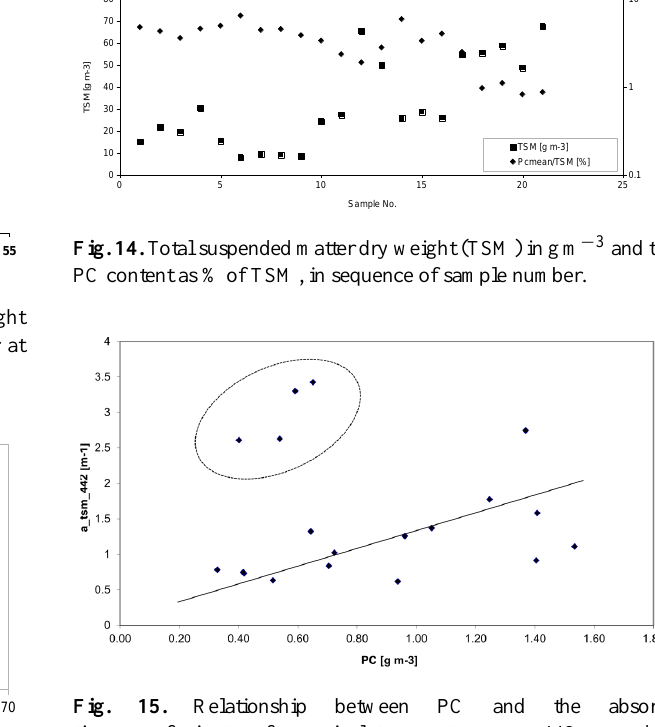
Fig. 15 Fig. 15. Relationship between PC and the absorp- tion coefficient of particulate matter at 442nm, data points within the circle are only from samples of 3 and 4 July 2011, when omitting these points the regression is a_TSM_442 < m − 1 > = 0.83 < m 2 g − 1 > · PC < gm − 3 > + 0.26 < m − 1 >